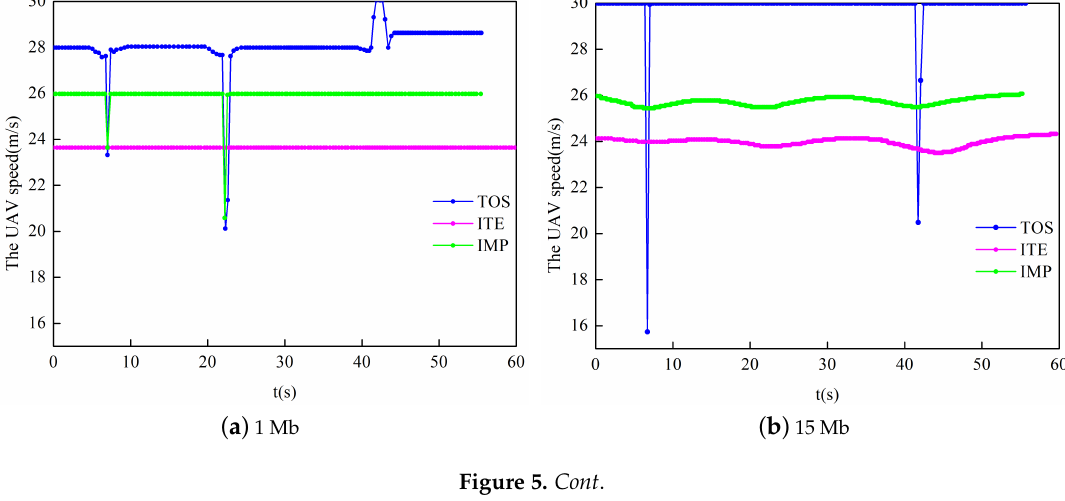
Figure 4. According to different data requirements, the trajectory comparison of UAV.